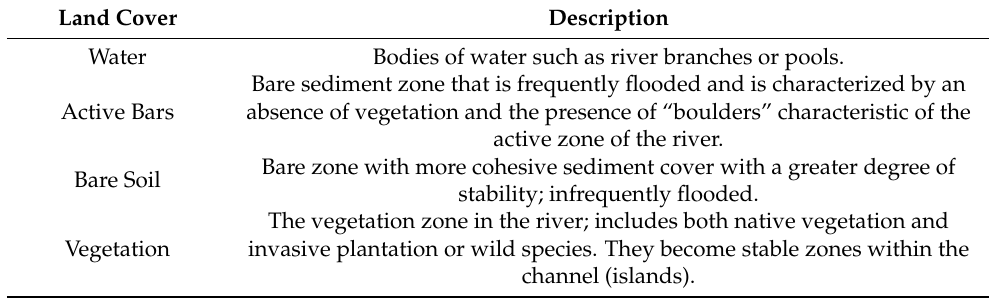
Table 3. Land cover class